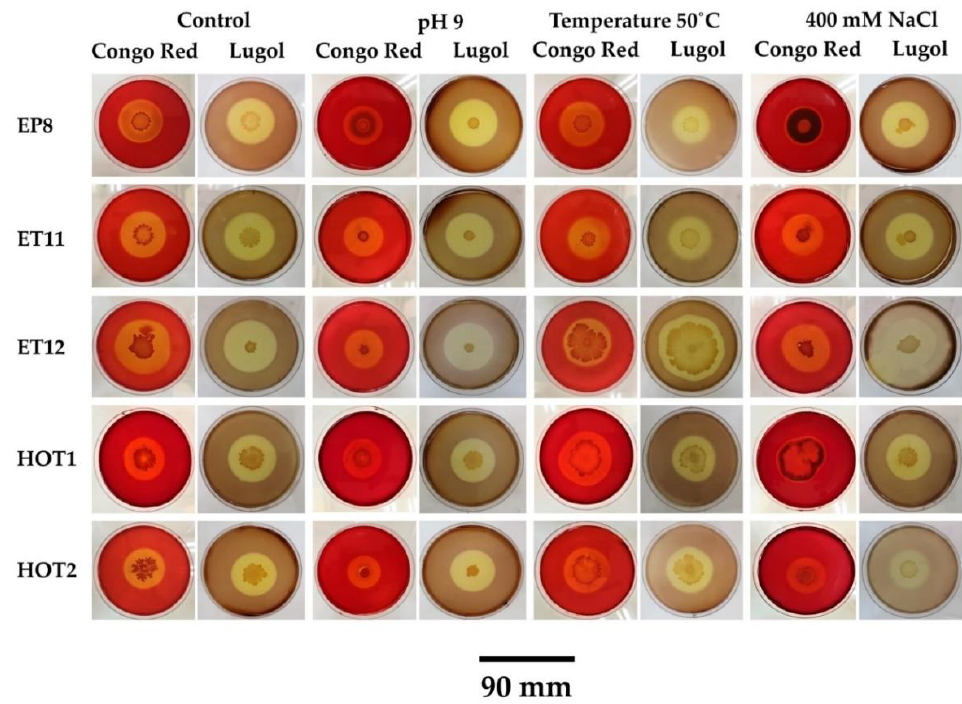
Figure 12. Illustration of the CMC hydrolysis zone by the strains tested in the presence of a single stress revealed by Congo red and Lugol solutions.